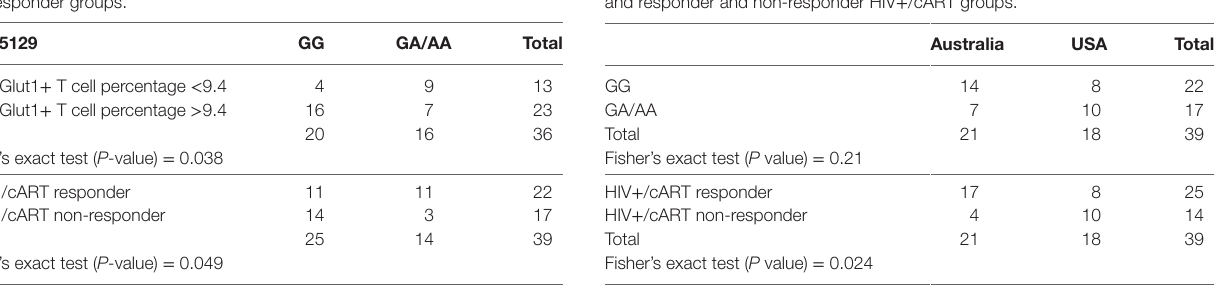
cART, combination antiretroviral